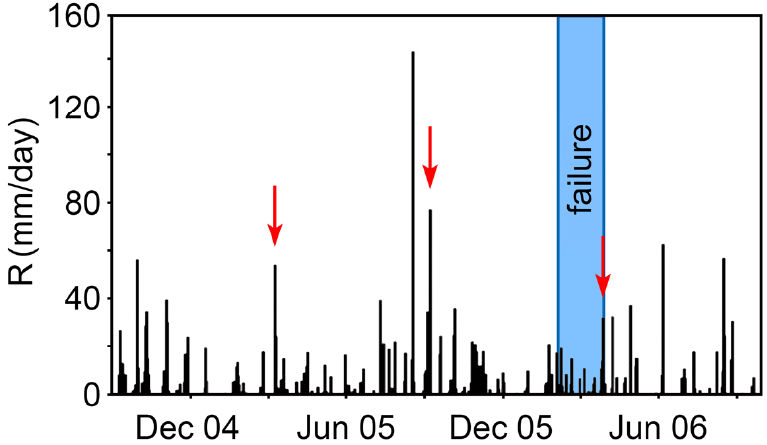
Figure 7. Available rainfall recordings (modified from [50]). Table 2. Rainfall intensity and initial suction for the events considered in the analyses (data drawn from [50]), along with the corresponding values of m w .